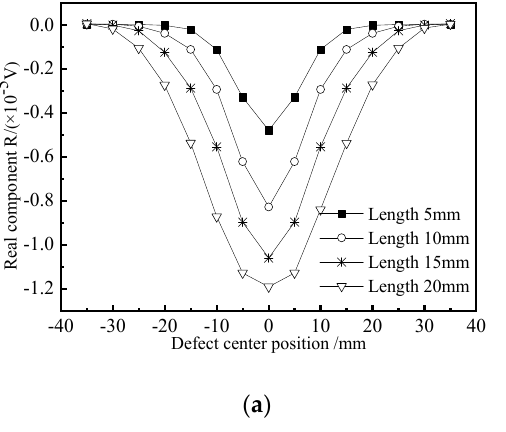
Figure 16. Crack defect detection signals of different lengths. ( a ) Real component; ( b ) Imaginary component.